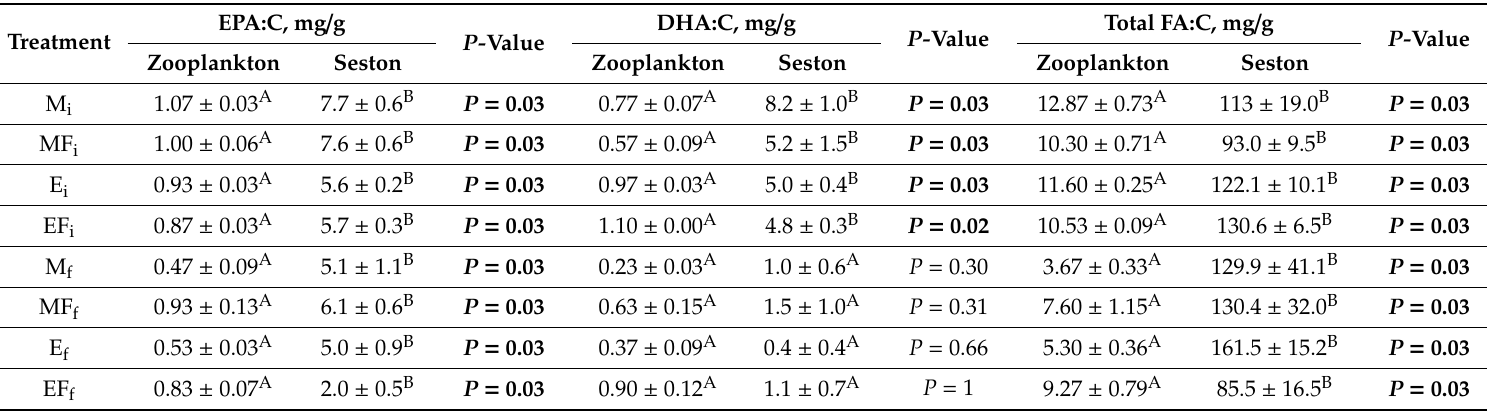
Table 8. Results of Mann–Whitney ( U ) comparing means ( ± SE) of contents per organic carbon (C) of indicators of nutritive quality of zooplankton and seston